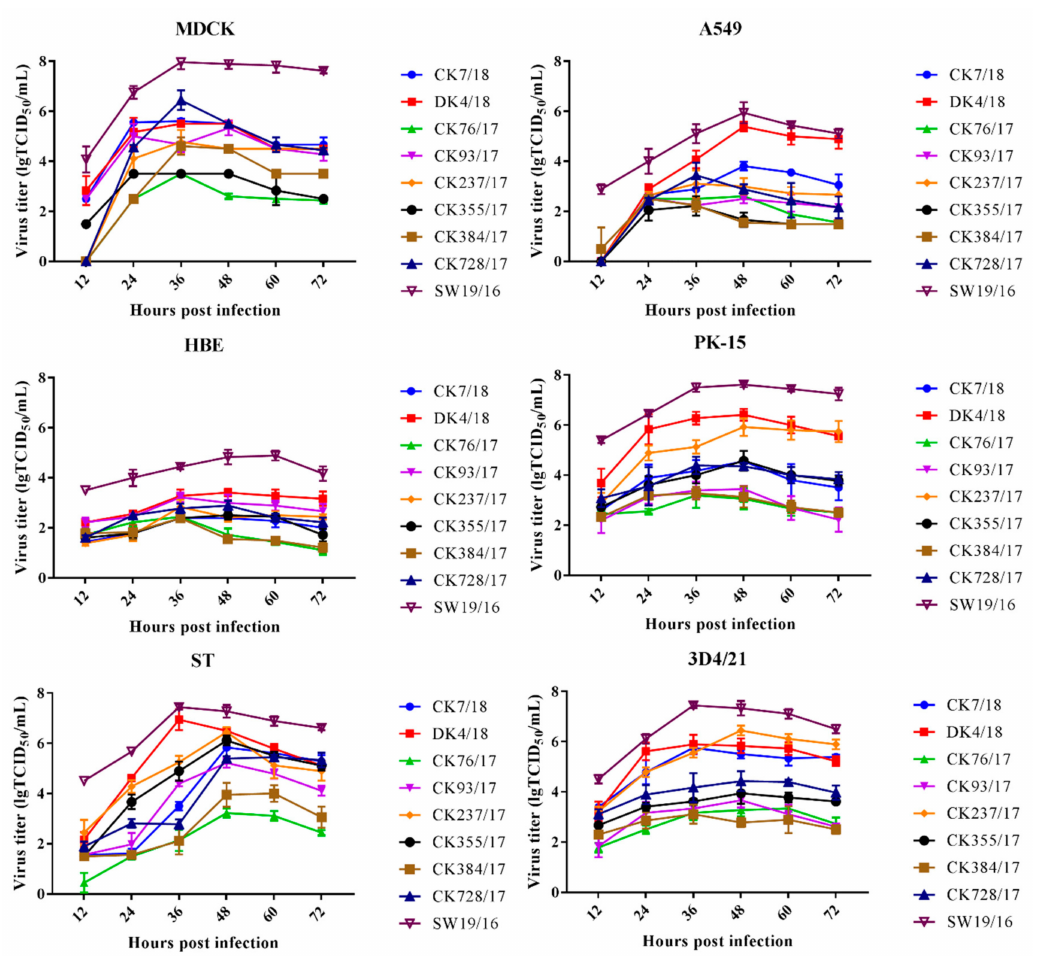
Figure 2. Replication kinetics of the eight H9N2 influenza viruses in di ff erent cells culture. Replication kinetics of viruses in Madin-Darby canine kidney (MDCK) cells inoculated with virus at a multiplicity of infection (MOI) of 0.001, in A549, HBE, PK-15, ST, and 3D4 / 21 cells inoculated with virus at an MOI of 0.01. A strain of H1N2 swine influenza virus, SW19 / 16, was used as control. The data of each time point indicates the mean ± standard deviation of three independent